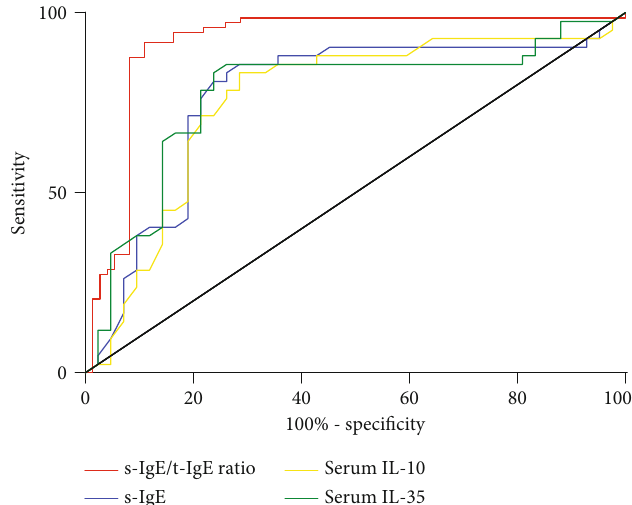
Figure 1: ROC curves obtained with the serum s-IgE/t-IgE ratio (decision point, 12.6%; sensitivity, 97.2%; and speci fi city, 74.1%), serum s- IgE levels (decision point, 34.6IU/mL; sensitivity, 83.3%; and speci fi city, 74.1%), serum IL-10 levels (decision point, 98.4pg/mL; sensitivity, 84.5%; and speci fi city, 72.1%), and serum IL-35 levels (decision point, 195.2pg/mL; sensitivity, 88.9%; and speci fi city, 70.6%) by plotting sensitivity in children with an e ff ective response to SLIT versus 100%-speci fi city in children with an ine ff ective response to